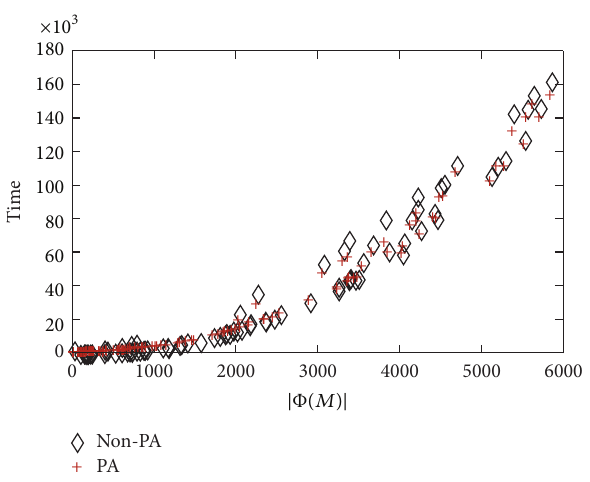
Figure 3: |Φ(𝑀)| versus execution time (in ms) when 𝑝 = 1 .